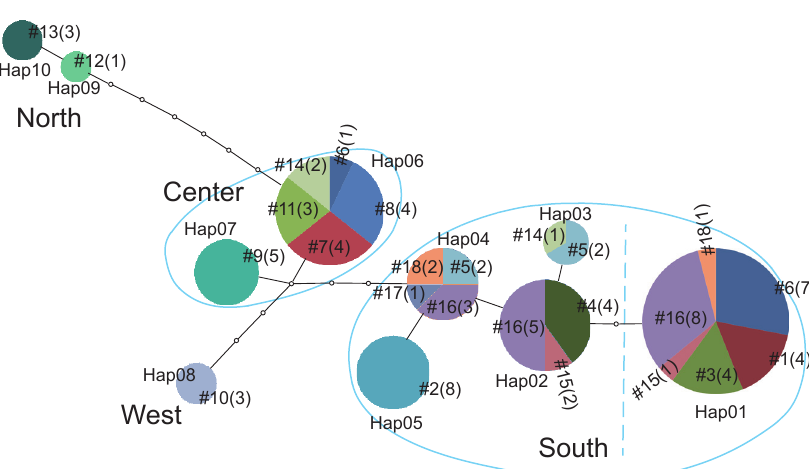
Figure 2. Parsimonious haplotype network of mitochondrial DNA sequences of Pseudorhodeus tanago (Hap01–10). Each line connecting haplotypes indicates one nucleotide difference. Small open circles stand for missing haplotypes. Locality number (#) and number of individuals observed (parentheses) in- dicate haplotype sharing. Blue solid lines encircle haplotype groups (north, center, west and south). Blue broken line indicates sub-grouping within the south haplotype group exhibited by SAMOVA analysis (right, south_1; left, south_2). Table 3. Haplotypes and variable sites of Pseudorhodeus tanago mitochondrial cytochrome b.